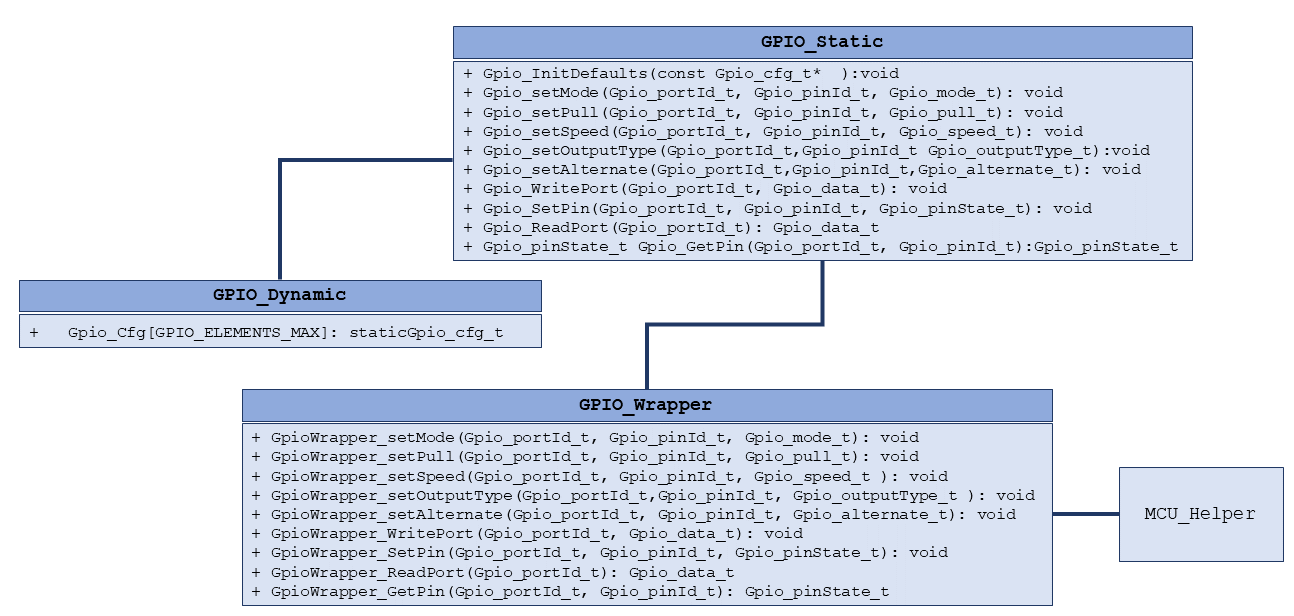
Figure 3. General Purpose Input/Outputs functions